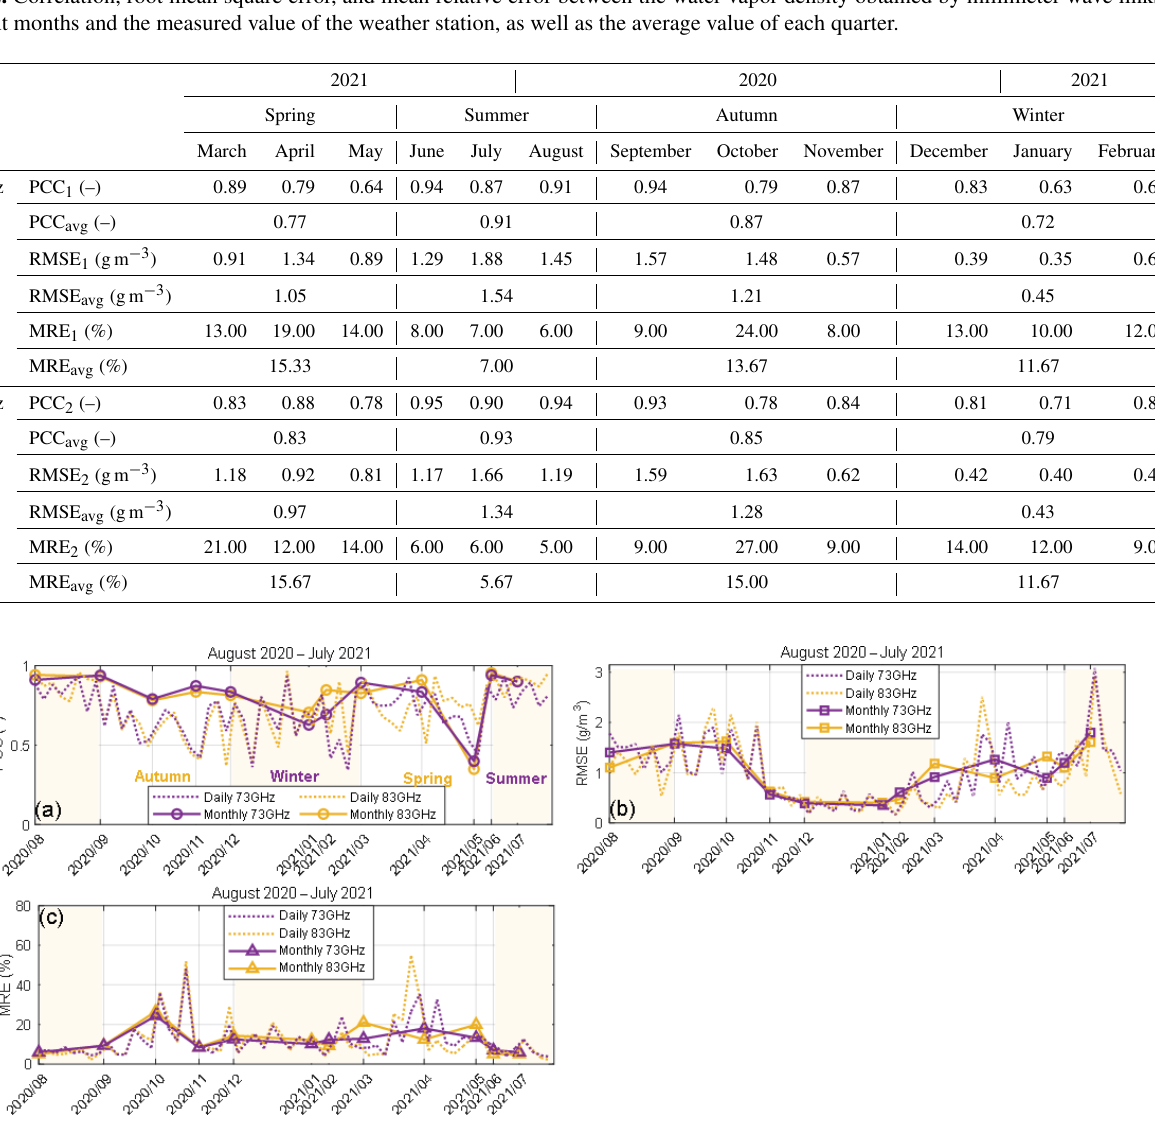
Figure 5. Daily and monthly evaluation index of water vapor density inversion. (a) The correlation between the derived water vapor density and the reference. (b) The root mean square error between the derived water vapor density and the reference. (c) The mean relative error between the derived water vapor density and the